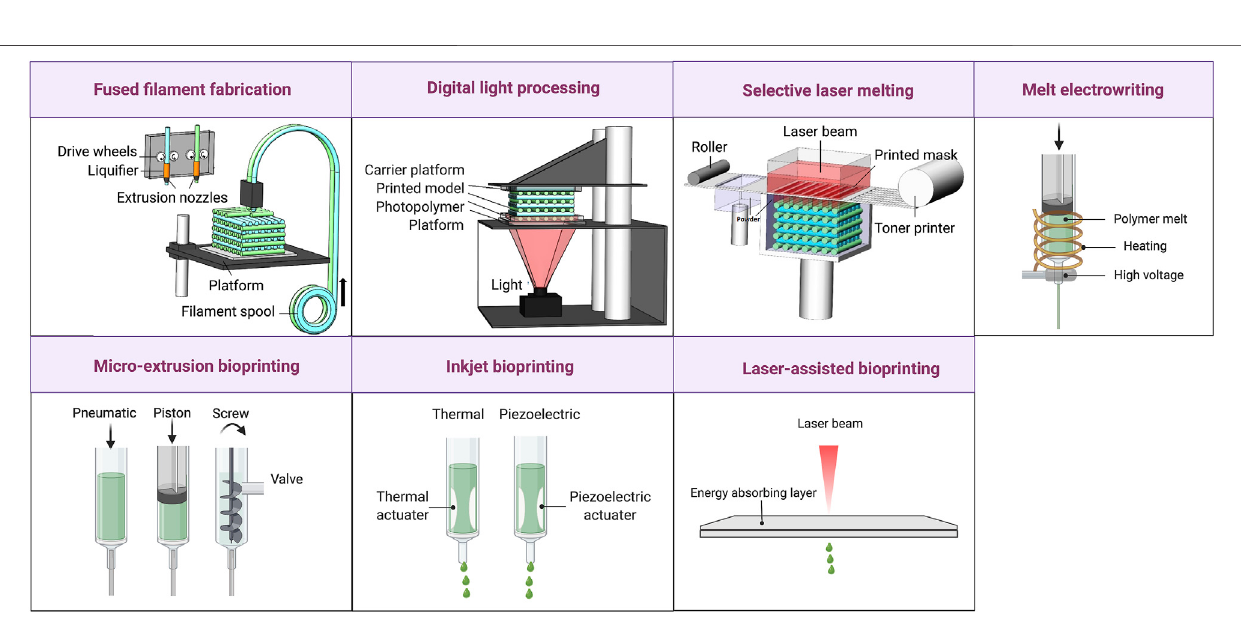
FIGURE 2 | The schematic representation of 3D printing and bioprinting techniques. 3D printing techniques such as fused fi lament fabrication (FFF), digital light processing (DLP), selective laser melting (SLM), and melt electrowriting (MEW). FFF is an extrusion approach for melted thermoplastic polymers. DLP is applicable for photopolymers. InSLM whichisapplicable forpowdermaterials,alaserbeamfusestheparticles. MEWisanozzle-basedmethod toextrude solvent-freepolymer fi bers in a high-voltage fi eld. Bioprinting methods are including micro-extrusion, inkjet, and laser-assisted bioprinting. Micro-extrusion works based on pneumatic or mechanical(pistonorscrew)dispension.Inkjetprintingejectsdropletsofmaterialbythermalorpiezoelectricpressure.Inlaser-assistedprinting,thematerialabsorbsthe laser energy and is ejected as a jet of bioink. Reproduced with permission of Touri et al. (2019).